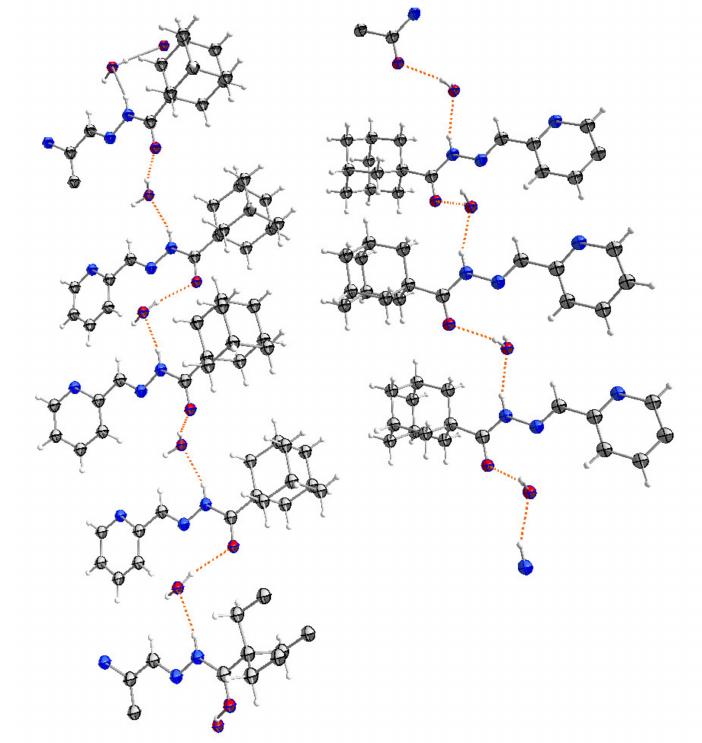
Figure 5. The packing diagram structures of APH with hydrogen bonds are shown as dotted